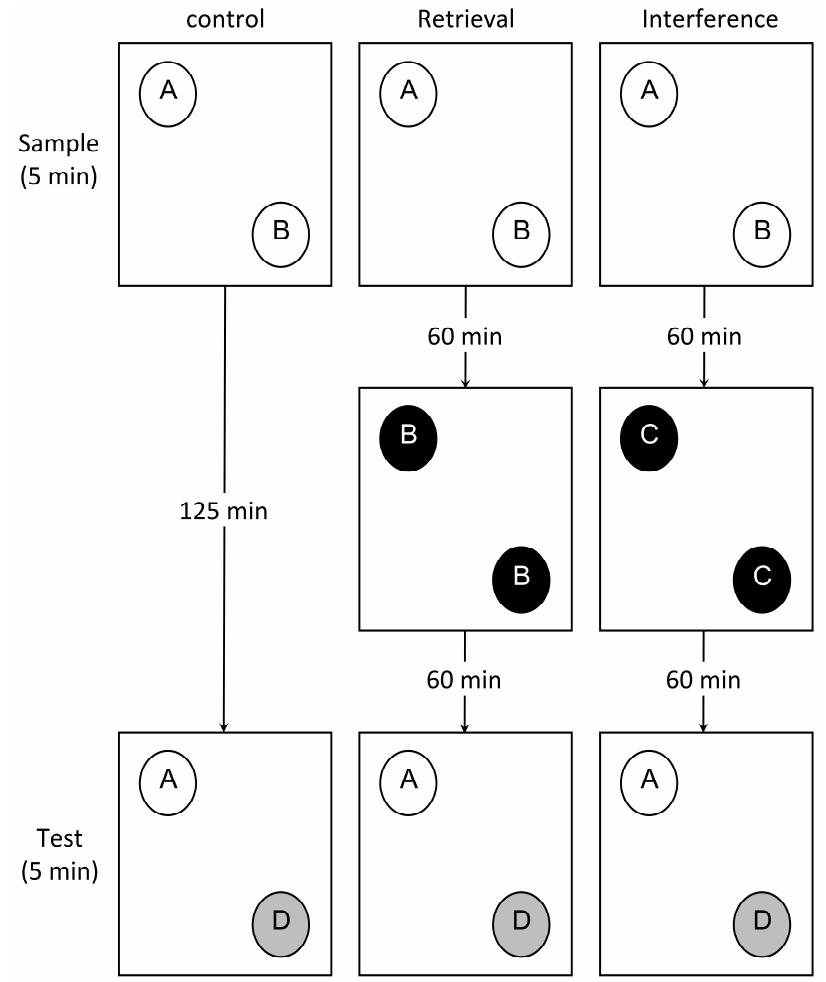
Figure 1. Modified object recognition test. In the sample phase, two different objects (A, B) were placed. One of these objects is replaced by a novel object in the test phase (A, D). For the retrieval group, two identical, related objects (B, B) were introduced in the delay period. For the interference group, two identical, unrelated objects (C, C) were introduced in the delay period. The animals were allowed to explore objects in each phase for 5 min, with a delay period (125 min) between the sample phase and the test